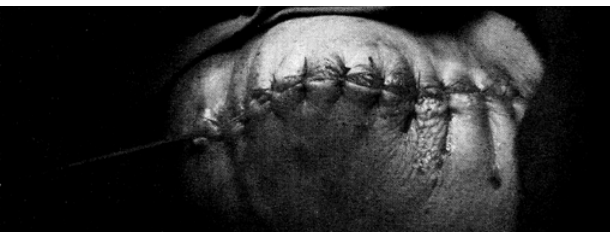
Fig 4: Amputation stump following